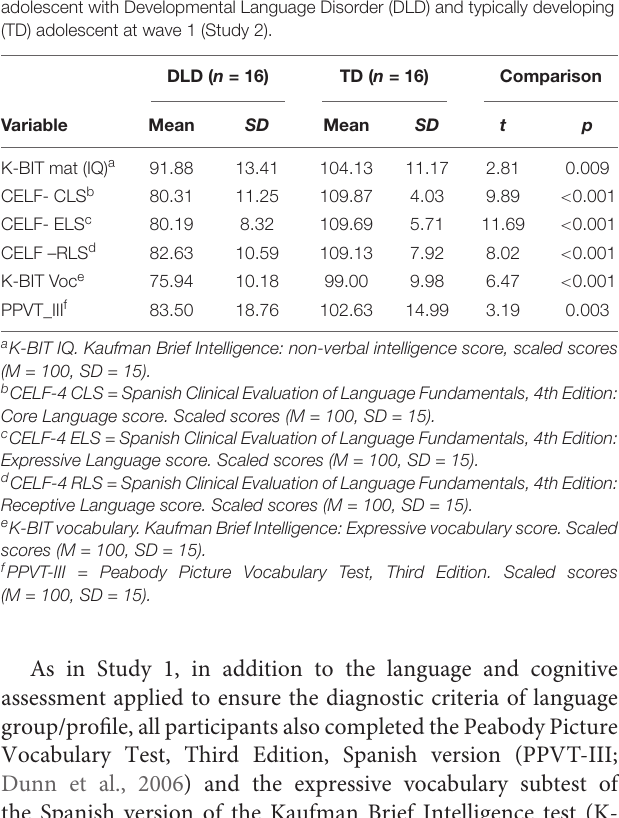
TABLE 5 | Socio-demographic characteristics of the adolescent with DLD and the typically developing (TD) adolescent (Study 2).